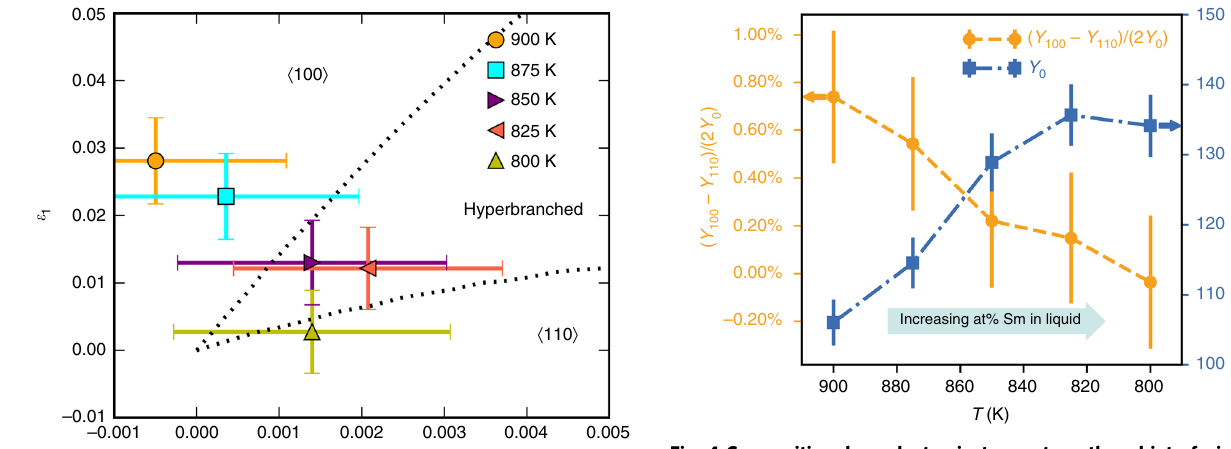
Fig. 4 Composition-dependent anisotropy strength and interfacial free energy. The data used are the same as those in Fig. 3. When plotted this way, it shows that the effect of Sm is to drastically reduce the anisotropy strength, meaning that the preference for h 110 i vs h 100 i dendrites discussed in relation to Fig. 3 is small. The error bars are calculated based on propagation of stiffness